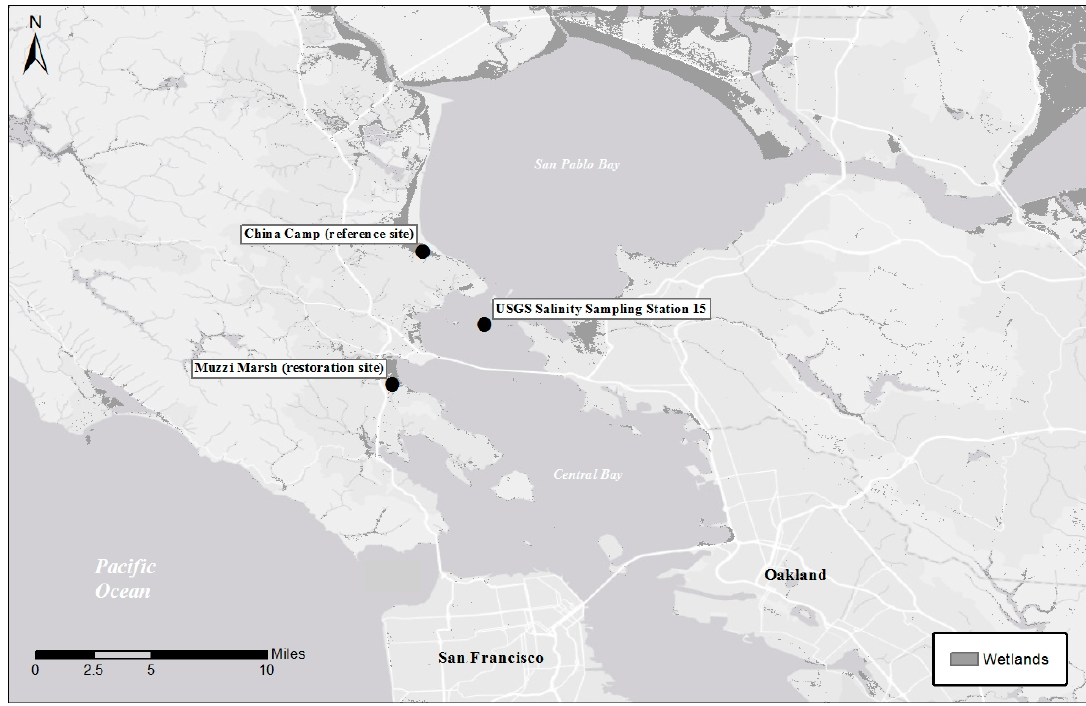
Figure 1. North SF Bay (San Francisco Bay) and study sites. Study sites: Reference site (China Camp)